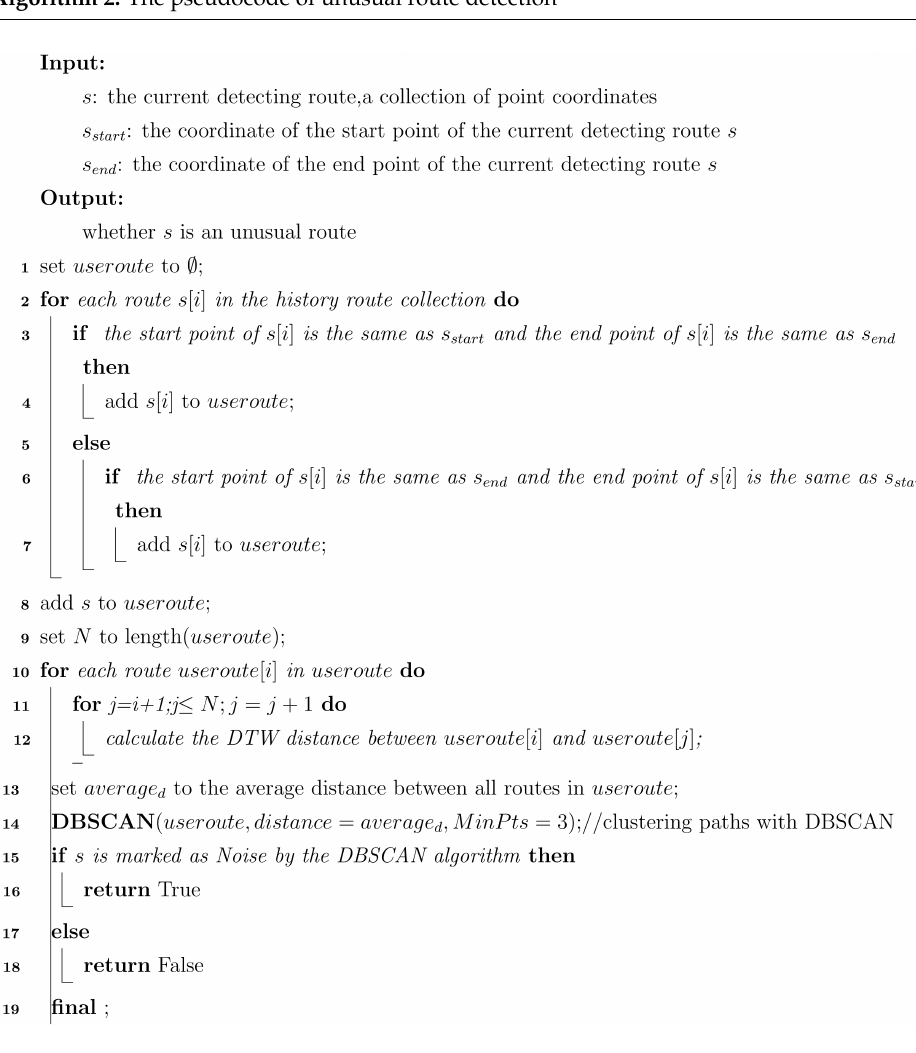
Algorithm 2: The pseudocode of unusual route